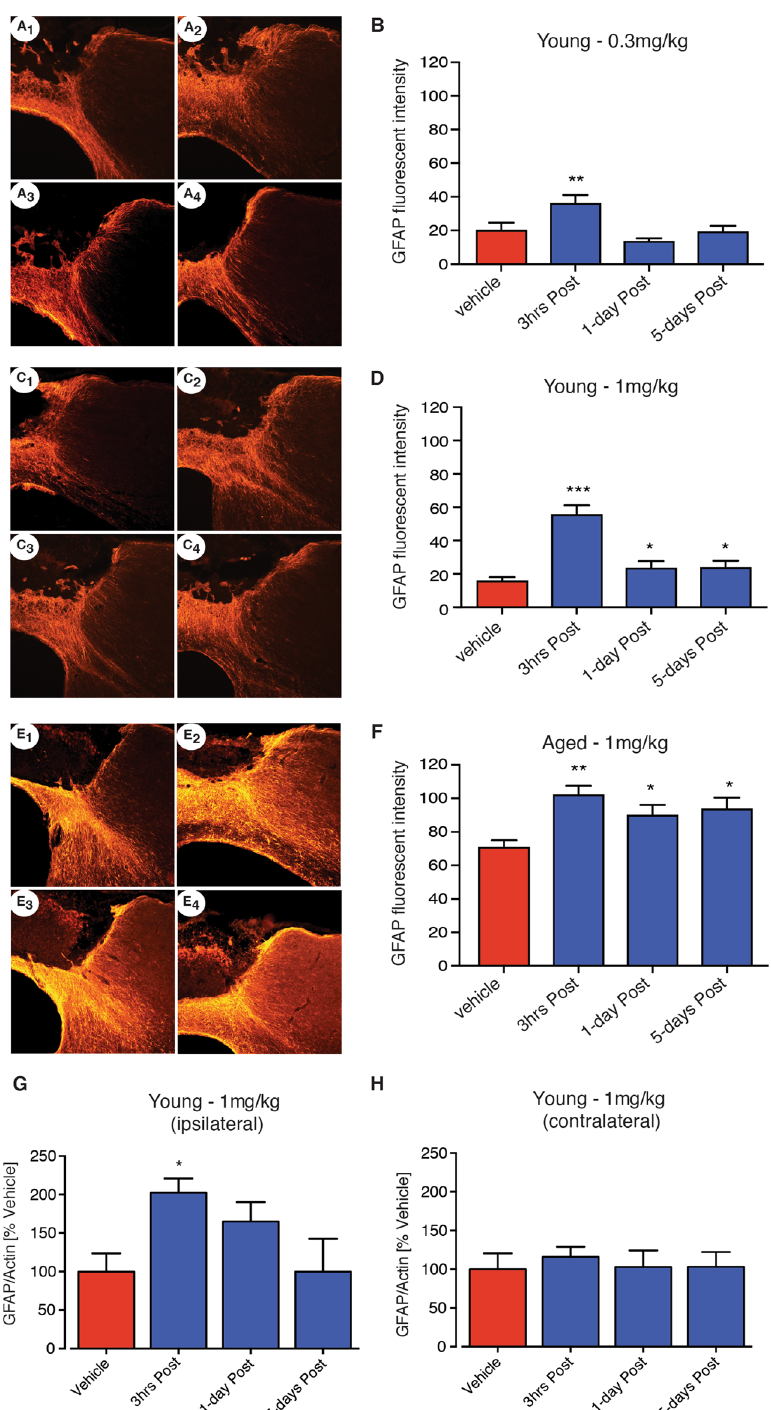
Figure 4. PEG-IGF-I reactive astrogliosis as assessed by GFAP labeling after stroke in both young and aged mice 14-days post-stroke. Representative images of GFAP staining are shown for stroke + vehicle, stroke + PEG-IGF-I from 3 hrs, stroke + PEG-IGF-I from 1-day and stroke + PEG-IGF-I from 5-days post- stroke for young 0.3 mg/kg ( A1 , A2 , A3 and A4 respectively), young 1 mg/kg ( C1 , C2 , C3 and C4 respectively) and aged 1 mg/kg ( E1 , E2 , E3 and E4 respectively) animals. Fluorescent intensity measurements for GFAP were obtained from peri-infarct regions of both young ( B for 0.3 mg/kg and D for 1 mg/kg) and aged ( F for 1 mg/kg) mice treated with vehicle or PEG-IGF-I. Of note the relative fluorescent intensity measures were approximately 3-fold higher in the aged than young. Western blot analysis was also performed on tissue isolated from both ipsilateral (stroked side: G ) and contralateral (non-stroked side: H ) hemispheres of young animals treated with either vehicle or 1 mg/kg PEG-IGF-1. An n = 5 per group were used for these studies. * P < 0.05, ** P < 0.01, *** P < 0.001 compared to aged-matched stroke + vehicle-treated